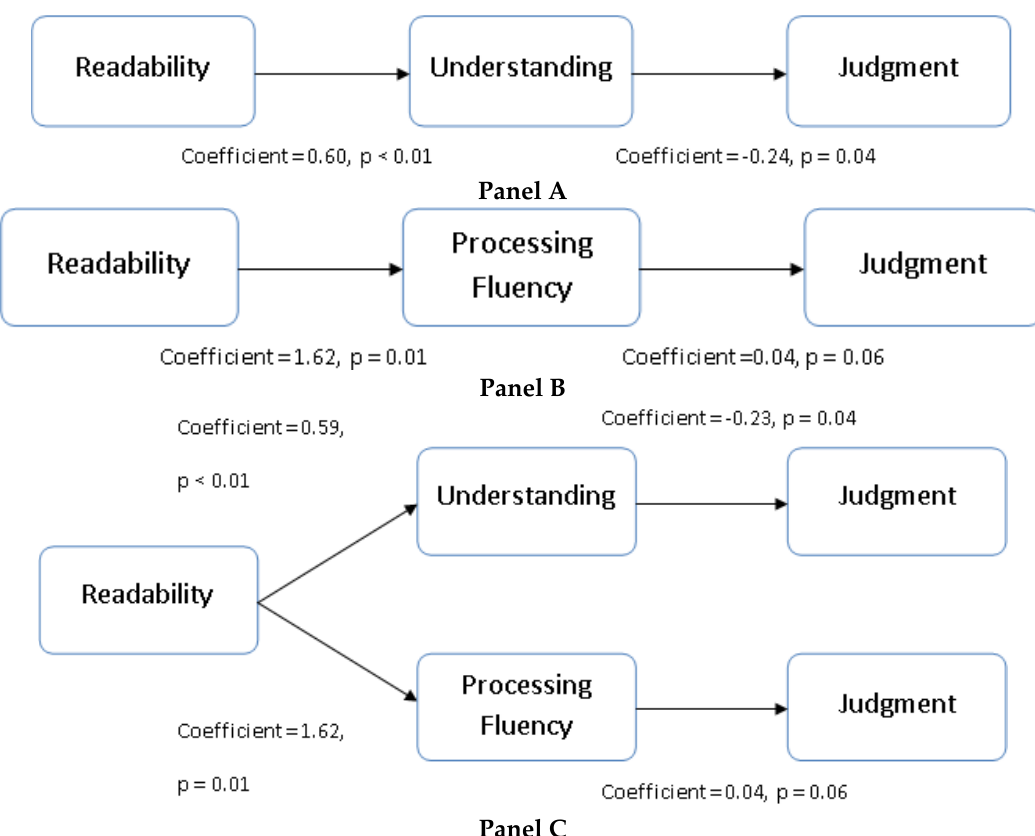
Figure 3. This figure shows structural equation modeling (SEM) results for the mediating role of understanding ( Panel A ); processing fluency ( Panel B ); and both understanding and processing fluency simultaneously ( Panel C ) when investor financial literacy is high. I present the standardized coefficients and corresponding p -values next to each step. When financial literacy is low, the relationship between readability (independent variable) and future firm performance judgment (dependent variable) is mediated by both understanding and processing.